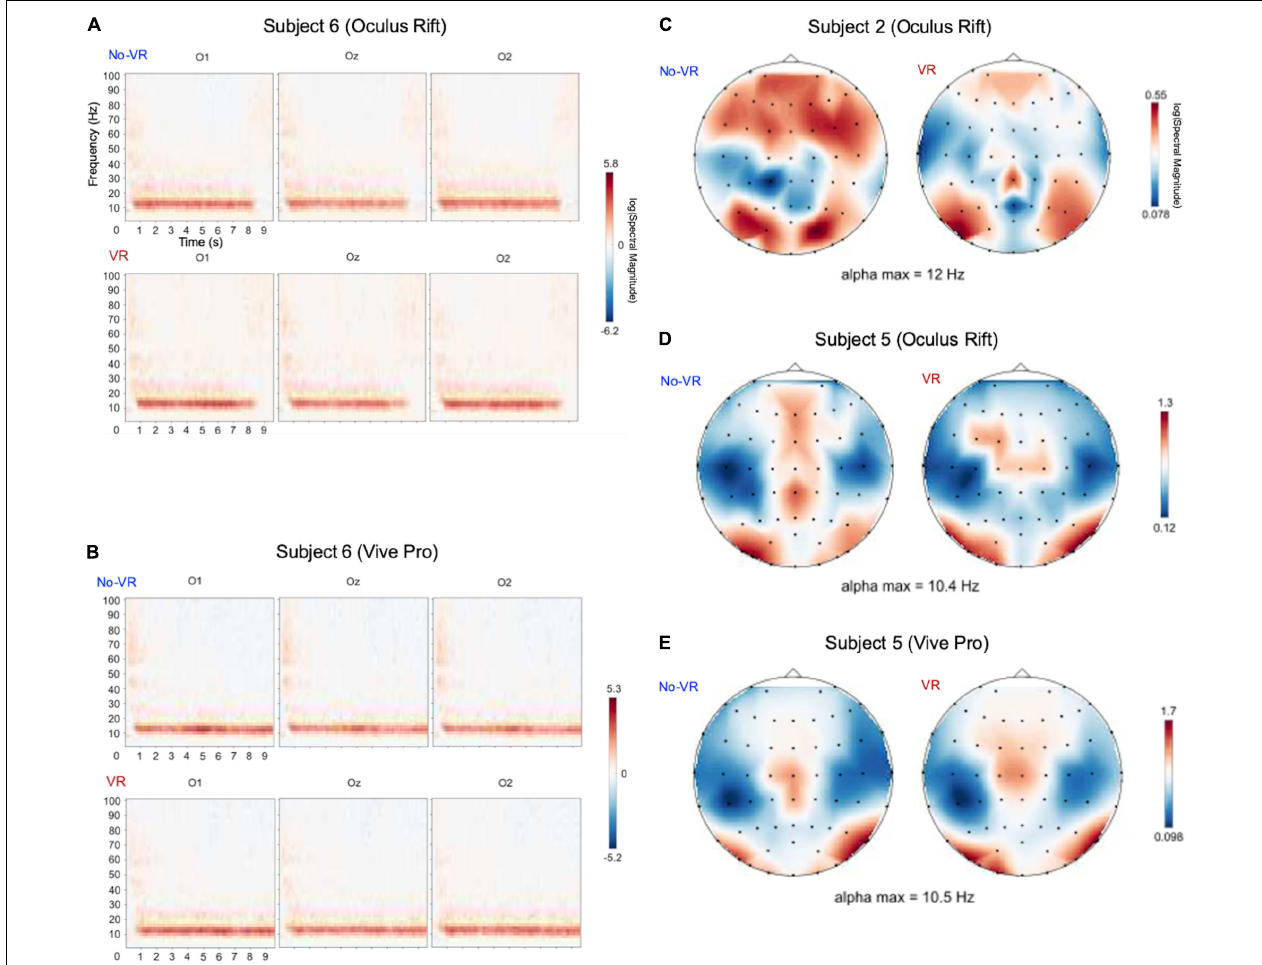
FIGURE 6 | (A,B) Increased alpha band ( ∼ at 12 Hz) response both in No-VR (A) and VR (B) conditions in subject 6 in the eyes-closed vs. eyes-open tasks, over the 10 s trial duration (T = 0 corresponding to start of task). (C–E) Topographic distributions of relative alpha power changes during eyes-closed vs. eyes-open conditions with and without HMD (relative spectral power in alpha peak frequency ± 2 Hz). The upper and lower rows represent VR and No-VR conditions, respectively, for different subjects and HMDs. Note that for all conditions, we find pronounced increased relative power in occipital and parietal electrodes. Within subjects, the changes between VR and No-VR were relatively small (compared to between-subject differences). Refer to Supplementary Figure 10 for all subject-specific topographic